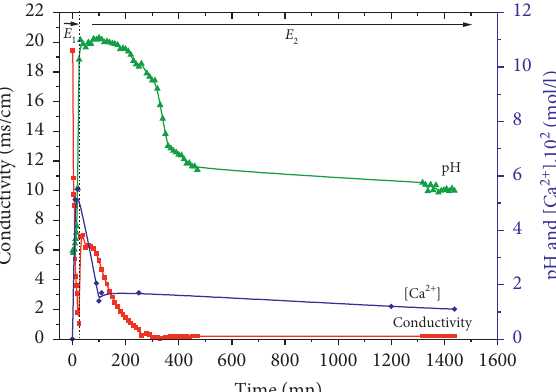
Figure 6: Evolution of the conductivity, pH, and Ca 2+ concentration versus time relative to mixture M